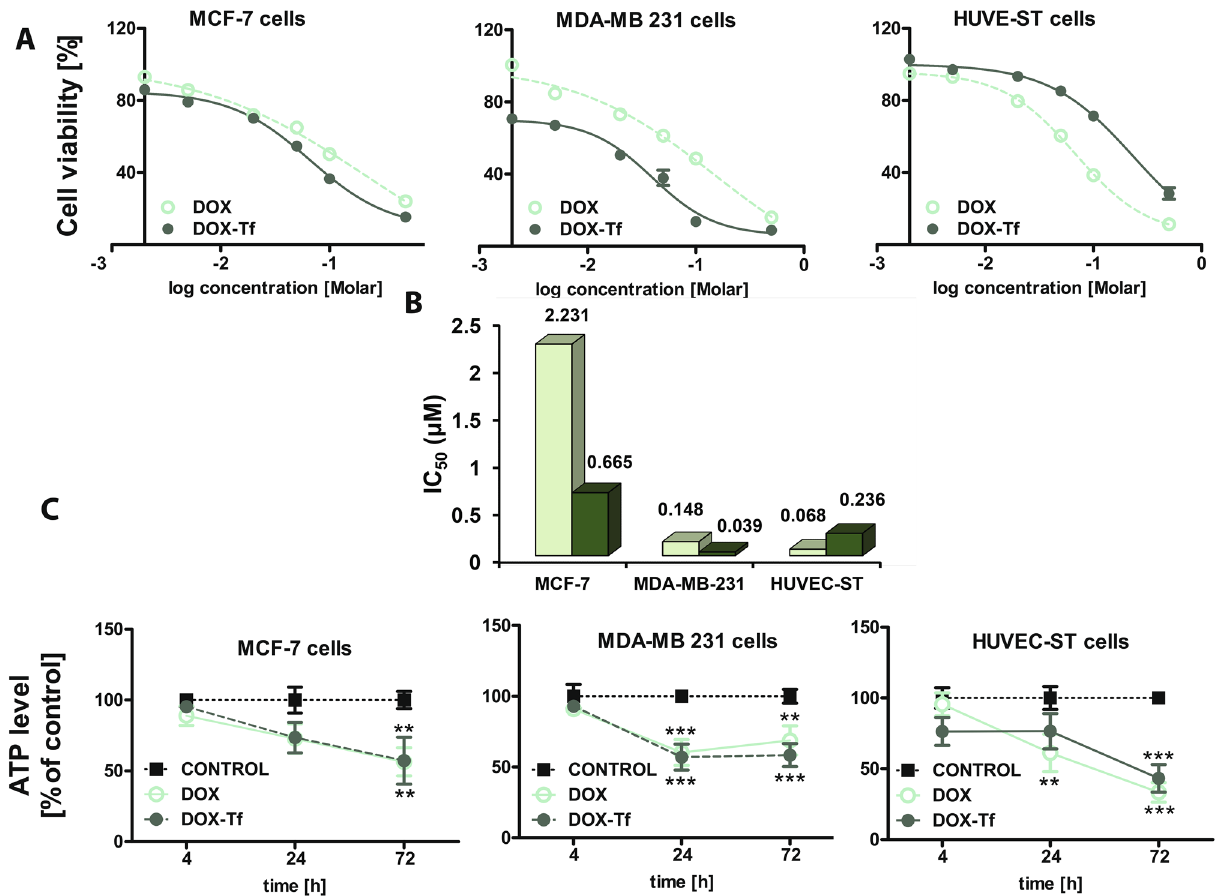
Figure 2. Comparisons of cytotoxicity of free DOX and DOX–Tf conjugate in breast cancer and endothelial cell lines. ( A ) Viability of MCF-7, MDA-MB-231 and HUVEC-ST cells measured by MTT assay after incubation of the cells for 72 h with increasing concentrations of DOX and DOX–Tf. The values are mean ± SD of five independent experiments with six replicates in each experiment. ( B ) IC 50 values (calculated on basis of cell viability curves) for free DOX and DOX–Tf conjugate in MCF-7, MDA-MB 231 and HUVEC-ST cells. ( C ) Cellular ATP level in MCF-7, MDA-MB-231, and HUVEC-ST cells treated with IC 50 concentrations of DOX alone or DOX–Tf for 4, 24 and 72 h. All values were normalized to untreated, control cells, taken as 100%. Data are expressed as mean ± SD (n = 6). Asterisks refer to the level of significance @@(** p < 0.01, *** p < mined the exact extent to which mitochondrial functions were influenced by DOX–Tf conjugate two breast cancer cell lines. We monitored different mitochondrial bioenergetics states of MCF-7 and MDA-MB-231 cells as well as HUVEC-ST endothelial cells (Fig. 1A). The cells were incubated with free DOX or DOX–Tf (at IC 50 concentration) for 4, 24 and 72 h. We observed a significant difference in the mitochondrial routine respiration between cancer and noncancer cells (Fig. 6A–C). MDA-MB-231 cells displayed reduced basic respiration in comparison to MCF-7 or HUVEC-ST cells. Besides, this in vitro model of triple-negative breast adenocarci- noma was the most sensitive to both forms of DOX. The respiration of MDA-MB-231 cells reached higher levels following 4 h incubation with DOX compared to DOX–Tf, which suggests the involvement of mitochondrial stress response pathways immediately after free DOX treatment. In order to assess the cellular ability to convert ADP to ATP during mitochondrial OXPHOS, we evaluated State D during mitochondrial respiration. The slowest rate of ATP production was observed in MCF-7 cells treated with both forms of DOX (independently of incubation time) (Fig. 6D–F). Additionally, MCF-7 cell line was more resistant to DOX–Tf toxicity than estrogen-negative breast cancer cells. In contrast to cancer cells, HUVEC-ST cells displayed a reduction in State D only after incubation with free DOX for 4 and 72 h. This observation is attributed to higher basic oxygen respirometric activity of HUVEC-ST cells in comparison to breast cancer cell lines. Finally, to evaluate the electron transport efficiency of mitochondria in the presence of DOX or DOX–Tf, we assessed the changes in the level of State E. MDA-MB-231 cells were less resistant to both forms of DOX than MCF-7 cells were (Fig. 6G–I). However, if treatment was continued for up to 72 h, the electron transport rate through the inner mitochondrial membrane was significantly inhibited in all cell lines.